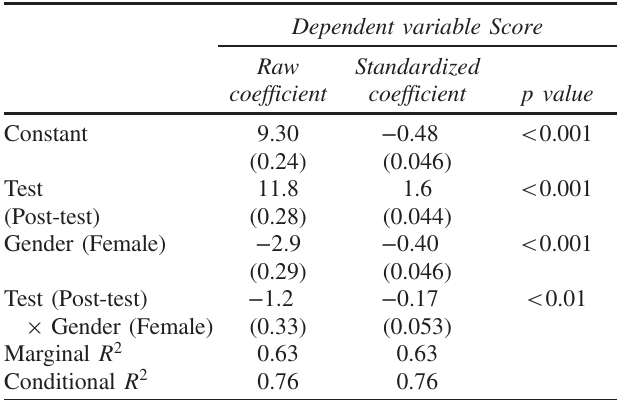
TABLE III. Raw and standardized coefficients from mixed effects analysis with PCSSW dataset. Raw coefficients, t sta- tistics, and p values are identical to those obtained from simple linear regression with gender as the only explanatory variable.